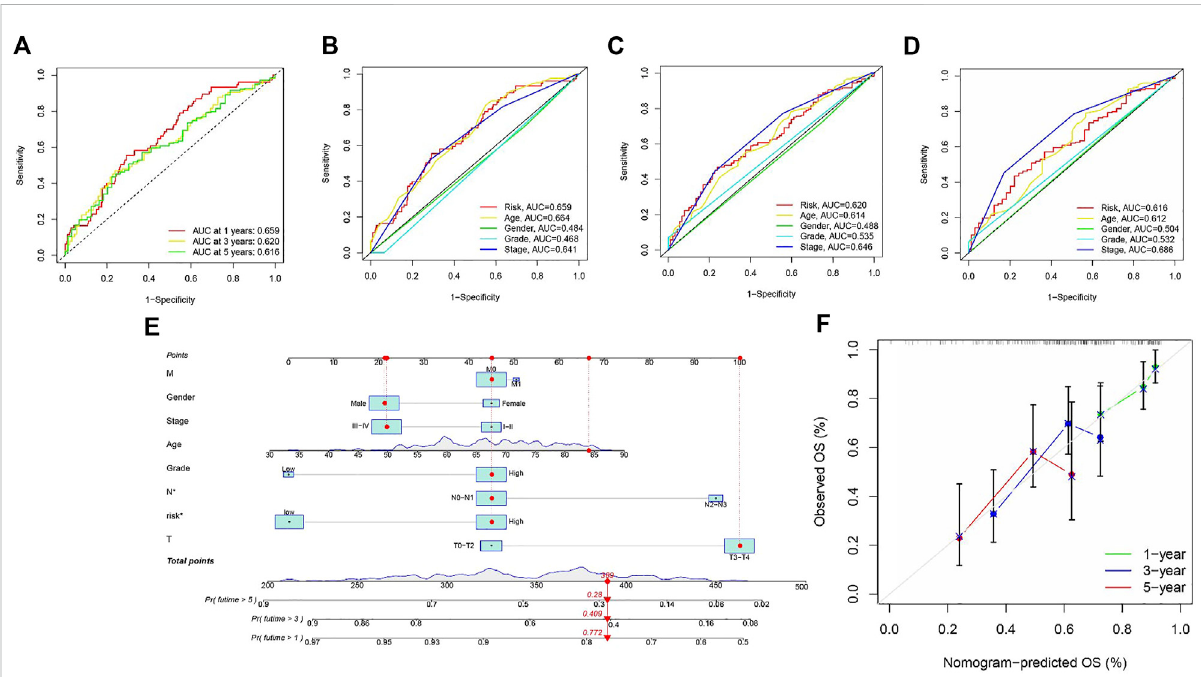
FIGURE 6 (A) ROC analysis is utilized to estimate the prediction characteristics of the prediction. (B – D) The prediction area under the risk assessment curve has other clinical characteristics of 1, 3, and 5-year total survival time. (E) Nomograms composed of clinical variables and risk characteristics were used to predict the survival rate of BLCA patients. (F) Calibration curves of 1-, 3-, and 5-year